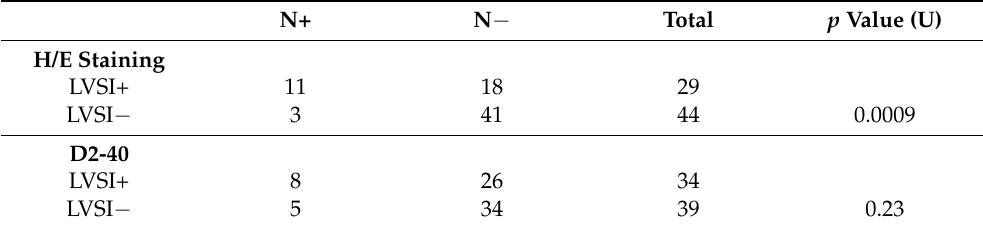
Table 3. Analysis between tumor emboli and lymph nodes status in H/E and D2-40 antibody